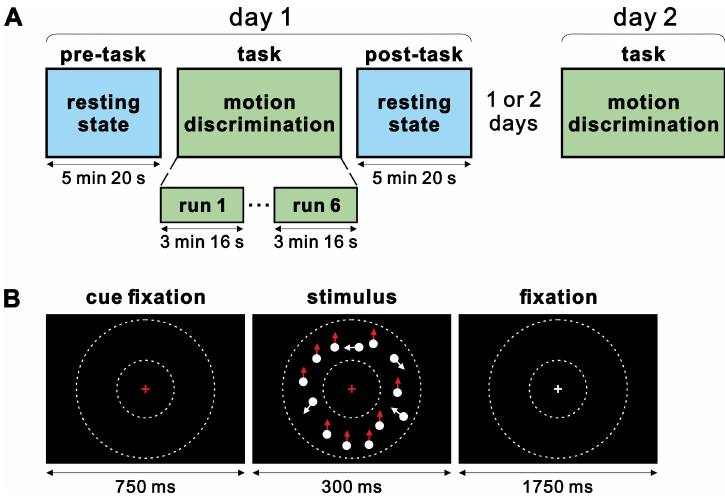
Fig 1. Experimental procedure and single trial of motion discrimination task. (A) Experiments were conducted over 2 days: day 1 and day 2. On day 1, fMRI scanning started with pre-task resting-state scans, followed by motion discrimination task scans, and post-task resting-state scans. On day 2, the same motion discrimination task was administered in the scanner. In each t-fMRI session (day 1 and 2), participants performed six runs of the motion discrimination task. (B) Each trial of the motion discrimination task began with 750-ms presentation of a red fixation cross cueing a subsequent visual stimulus comprised of coherently moving dots for 300 ms. The coherence level (20, 40, or 80%) and motion direction (upward or downward) varied from trial to trial. The color of the fixation cross became white when the dot stimuli disappeared and remained white for 1750 ms. Participants were required to press the corresponding button with their right thumb as quickly and accurately as possible within a response window of 1050 ms. The area in which moving dots were presented is schematically indicated in between the small and large dotted circles; these circles were not presented in actual